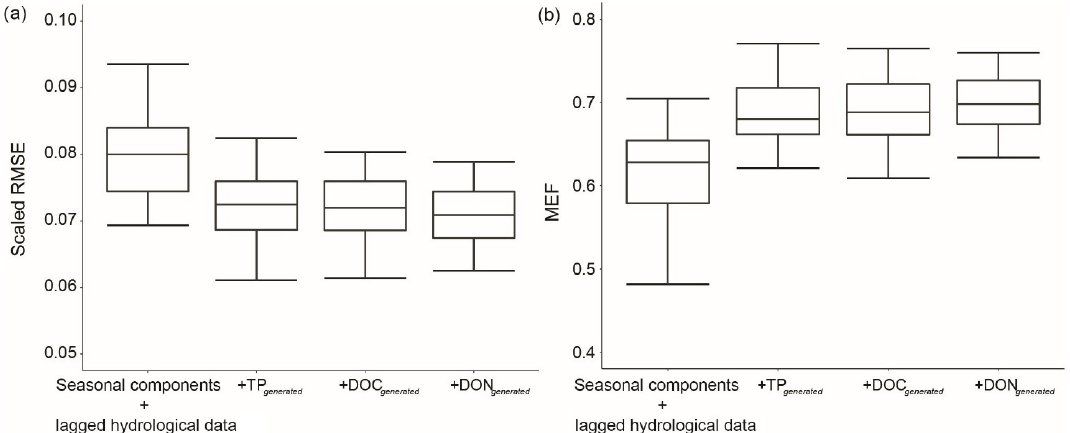
Figure 8. Model performance for TN prediction across different input variables for Ellen